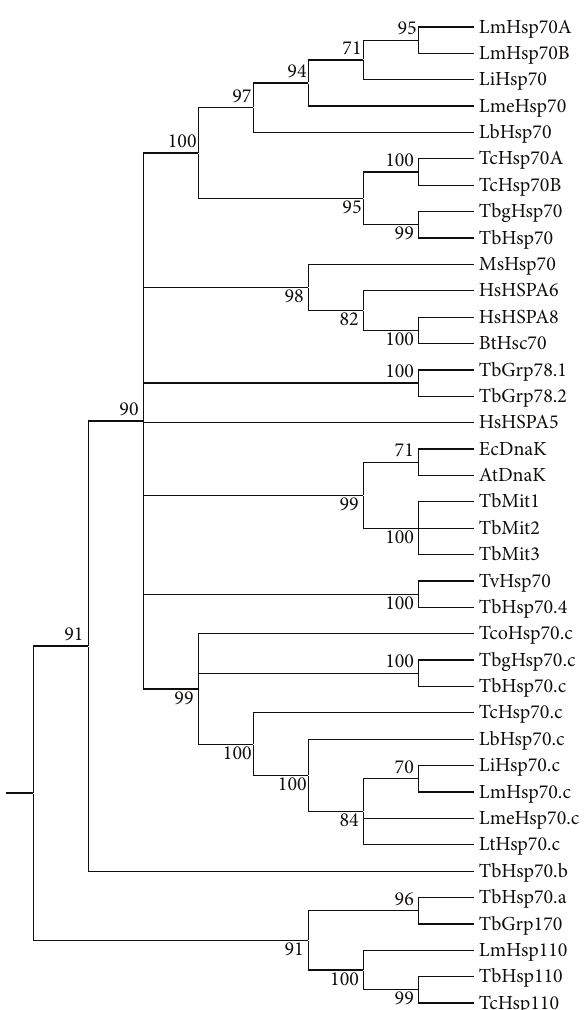
Figure 1: Phylogenetic analysis of Hsp70.c proteins from the TriTryps. Hsp70 amino acid accession numbers were obtained from GeneDB [41] and NCBI [42]. L. braziliensis Hsp70.c (GeneDB accession number LbrM.28.3030); L. infantum LiHsp70.c (GeneDB accession